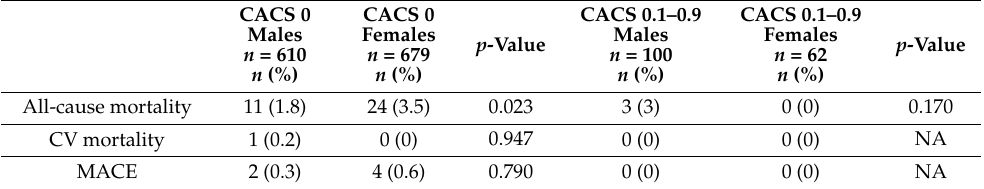
Table 6. All-cause mortality, CV mortality, and major cardiovascular event (MACE) rates between males and females with a CACS of zero and ultralow CCS (0.1–0.9) before propensity score matching ( n = 1451).